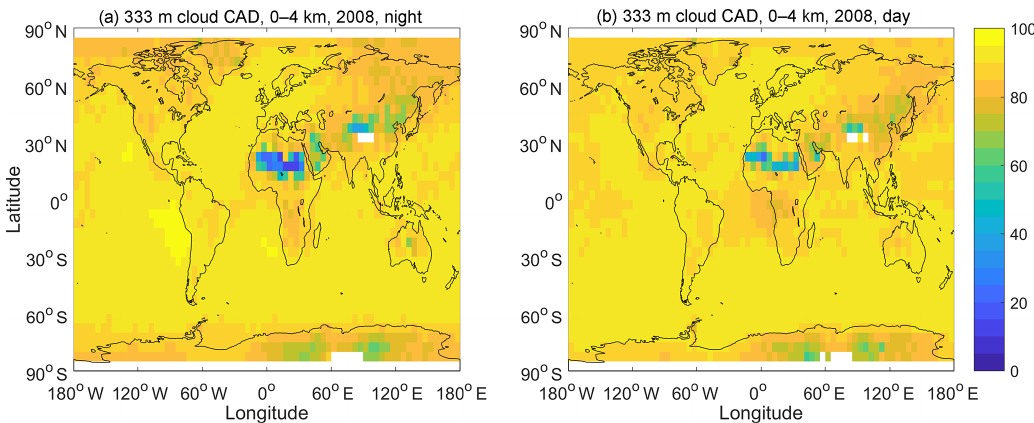
Figure 26. Spatial distributions of the CAD scores for all 333m cloud layers detected between 0 and 4km in 2008 for (a) nighttime and (b) daytime